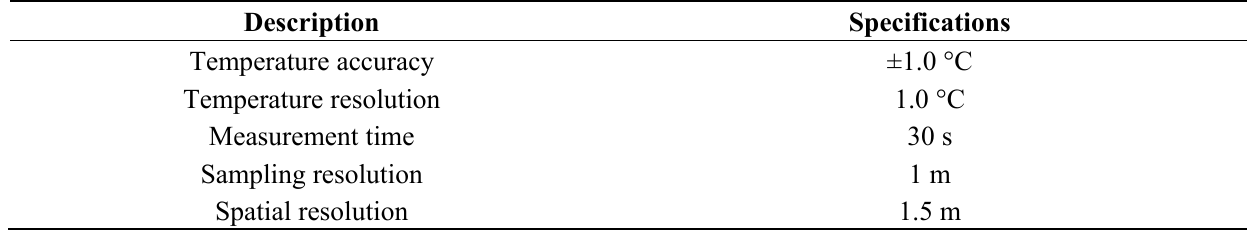
Table 1. Performance index of